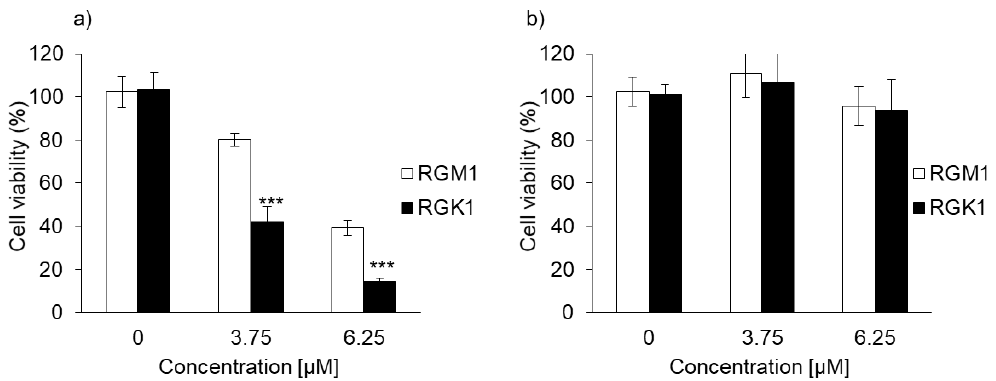
Figure 3. The cytotoxicity effect of PDT using ( a ) PLP and ( b ) laserphyrin. Data are expressed as means ± SD ( n = 5). *** p < 0.001.